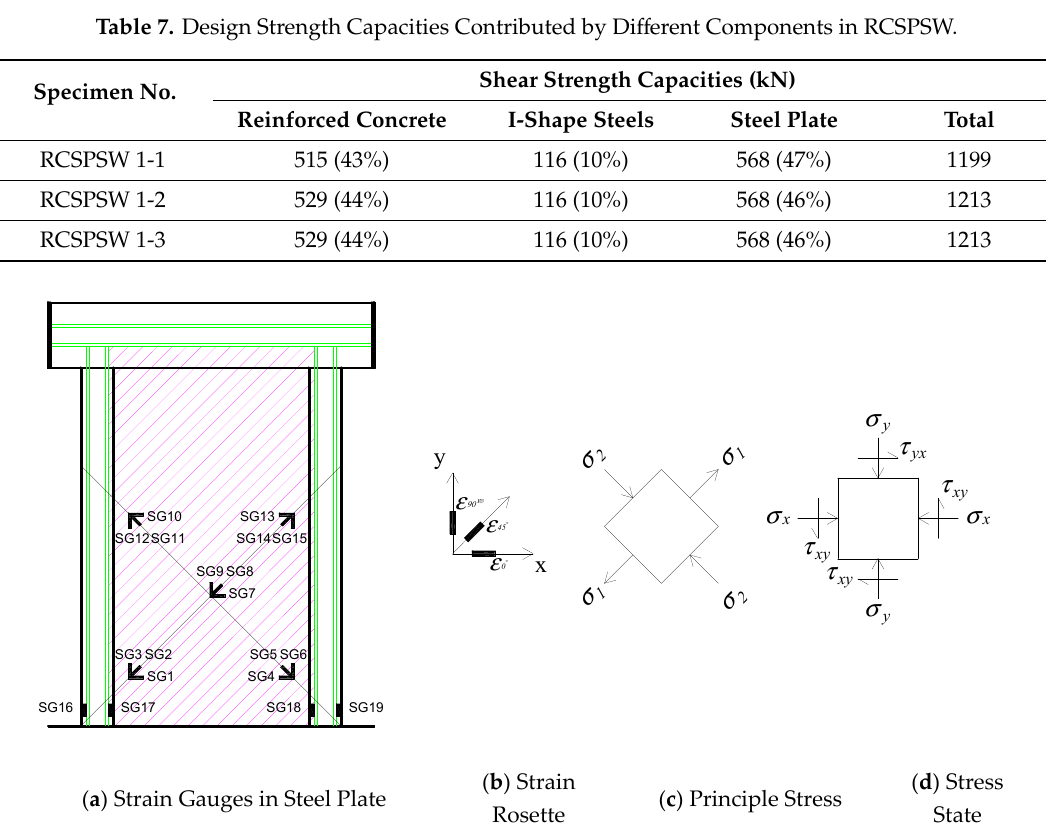
Figure 17. Shear Strength of I-shape Steels and Steel Plate Inferred from Strain Gauge Readings ( a ) Strain Gauge Arrangement in the I-shape Steels and Steel Plate; ( b ) Strain Rosette; ( c ) Principle Stress State; and, ( d ) Required Stress State.